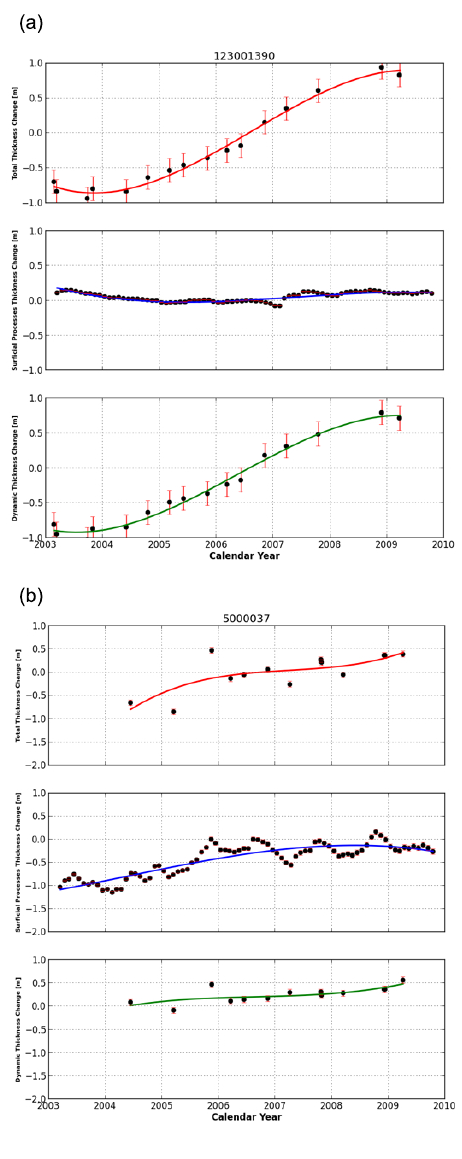
Figure 2. Total, surficial process (SMB and firn-compaction) and ice dynamic related ice sheet thickness changes, examples from Antarctica. Left: Pine Island Glacier (630 meter), right: EAIS Plateau (3,331 meter).